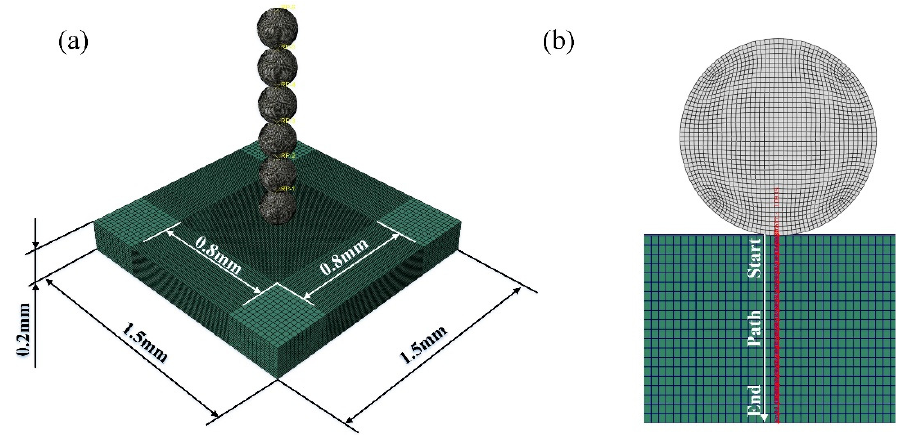
Figure 6. Finite element model of multiparticle shot peening: ( a ) multiparticle model for macroscopic simulation; ( b ) the stress and strain extraction path.